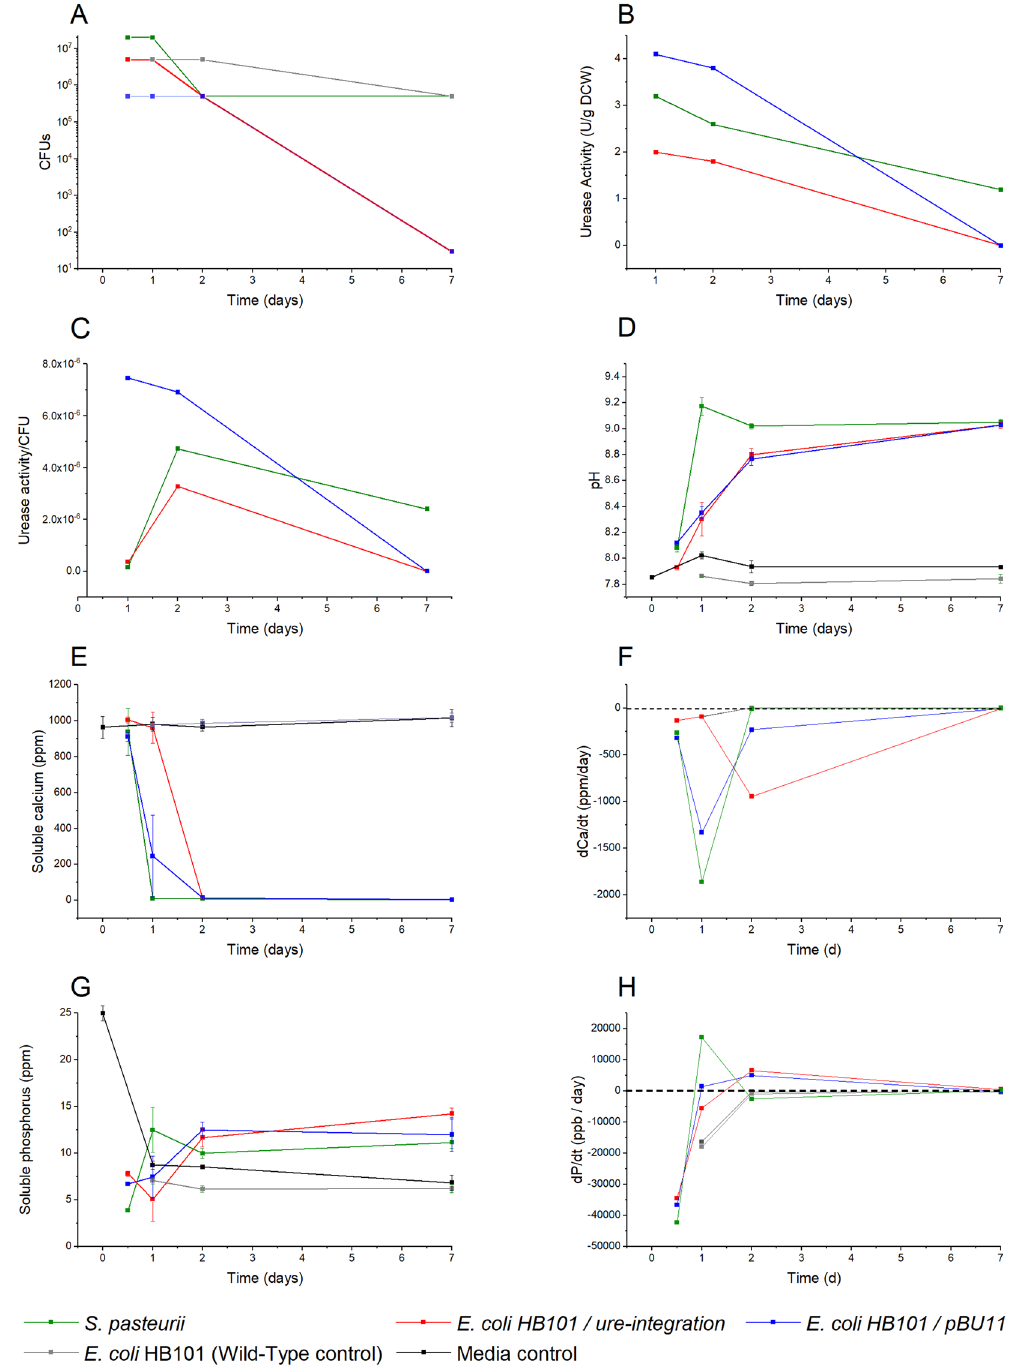
Figure 1. Cell growth and precipitation kinetics throughout 7d. ( A ) Colony forming units were measured for microorganisms. All strains retained viability throughout the 7d experiment. ( B ) Urease activity declined across the 7d experiment for all microorganisms. ( C ) Urease activity normalized to CFUs was at a maximum at 1d for E. coli HB101/pBU11 and 2d for the other two ureolytic microorganisms ( D ) Native and engineered ureolytic microorganisms raised the solution pH, although at different rates. ( E ) Soluble Ca was depleted at different times for ureolytic strains; the slowest total Ca depletion was observed for the engineered strain with the lowest urease activity, E. coli HB101/ure-integration. Ca was slightly lowered in controls with the precipitation of CaP. ( F ) The rate of calcium depletion, dCa/dt, differed by microorganism. The dCa/dt at beginning of calcite nucleation (12h for S. pasteurii and E. coli HB101/pBU11, 1d for E. coli HB101/ure-integration) was related to the urease activity of the microorganism and inversely related to calcite crystal size at the study endpoint. ( G ) Soluble P initially decreased for ureolytic strains and control conditions with the spontaneous precipitation of CaP. ( H ) The rate of P depletion in solution, dP/dt, varied with microorganism such that phosphorus was initially depleted and then returned to solution with calcite